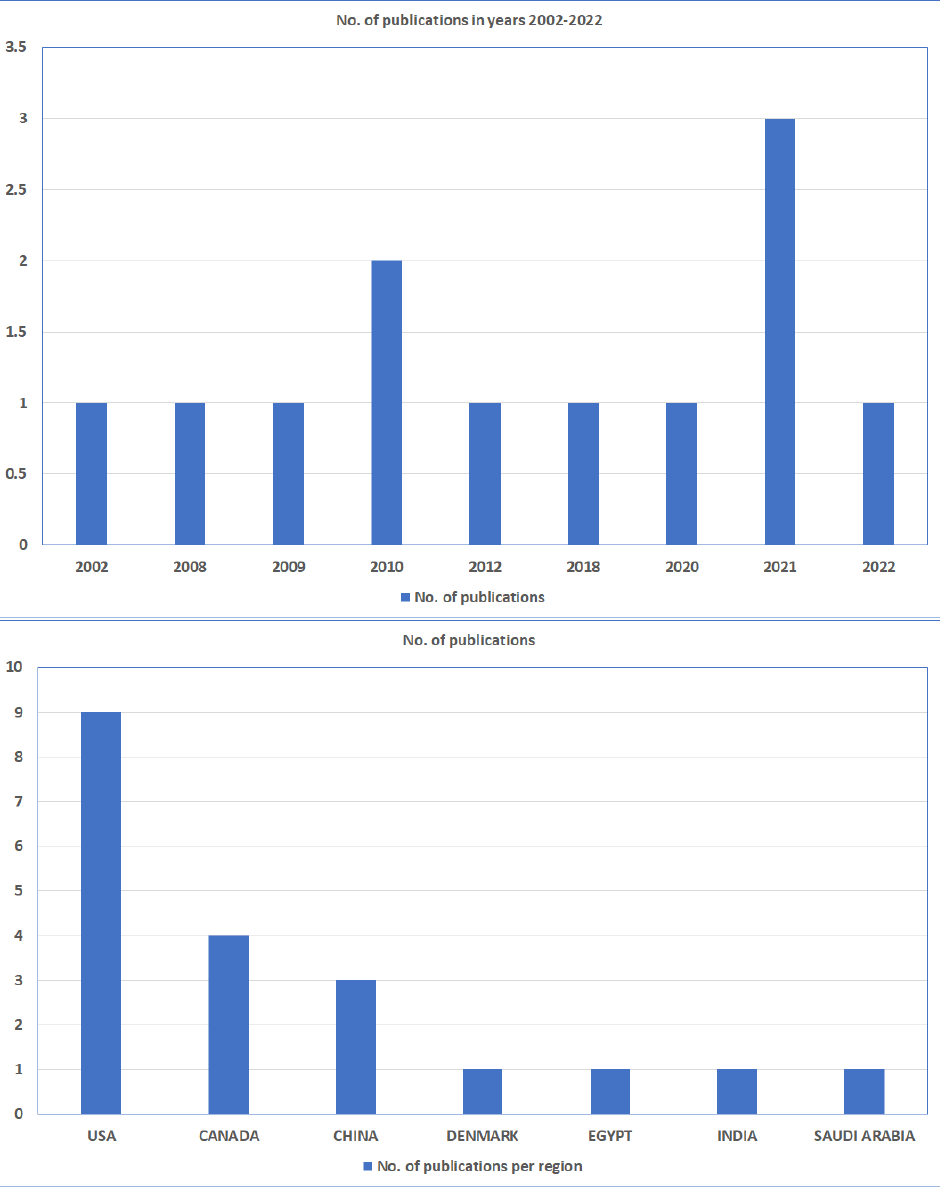
Figure 1. Number of responses as a function of time and region for WOS database search phrases: “blueberry” and “yield prediction” or “blueberry” and “yield forecast” or “blueberry” and “yield estimation” (September